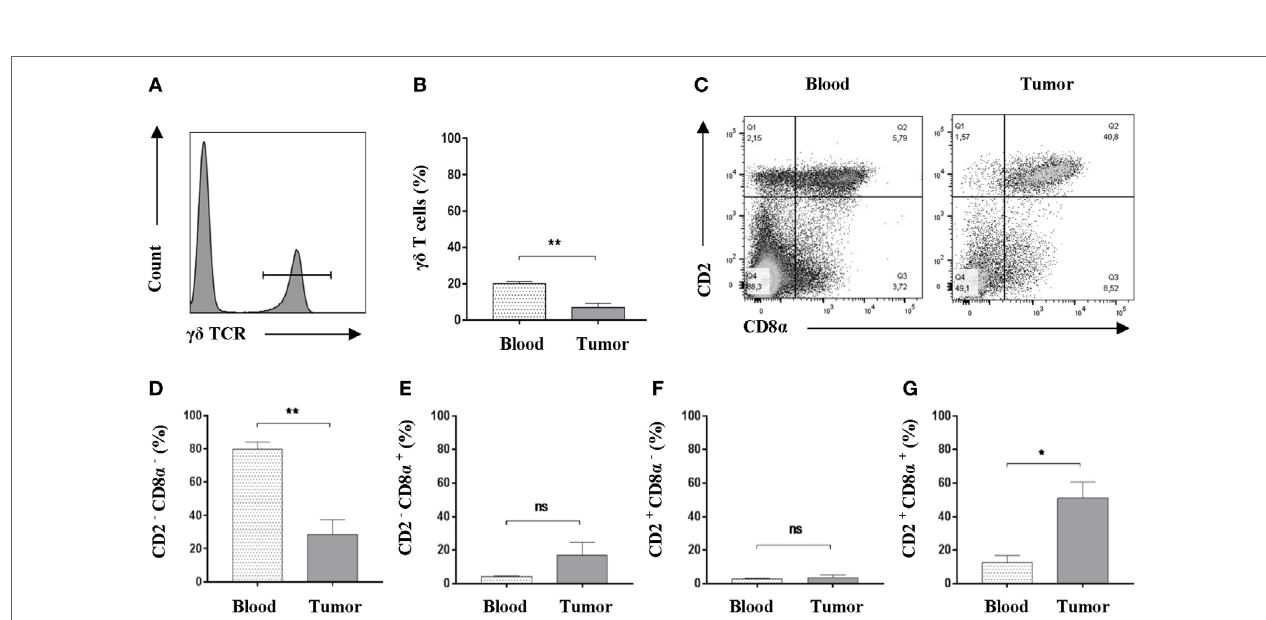
FigUre 4 | An increased representation of CD2 + CD8 α + γδ T cells is found within Oncopig tumors. Oncopigs were subcutaneously injected with AdCre. Peripheral blood and tumor samples were harvested 7–21 days post injection and analyzed by flow cytometry. All cells were pre-gated on viable, single lymphocytes. (a) γδ T cells were detected by expression of the δ chain of the T cell receptor in viable, single lymphocytes. Representative flow cytometric plot is shown. (B) Representation of γδ T cells as a percentage of viable, single lymphocytes in tumor and peripheral blood. (c) Representative flow cytometric plots of CD2 and CD8 α expression in γδ T cells obtained from peripheral blood (left plot) and tumor isolates (right). (D) Percentage of CD2 − CD8 α − cells in viable γδ T cells. (e) Percentage of CD2 − CD8 α + cells in viable γδ T cells. (F) Percentage of CD2 + CD8 α − cells in viable γδ T cells. (g) Percentage of CD2 + CD8 α + cells in viable γδ T cells. Bars represent mean ± SEM, and data are from one experiment ( n = 5 ). Statistical evaluations were performed by paired Student’s t -test (* P < 0.05 and ** P <